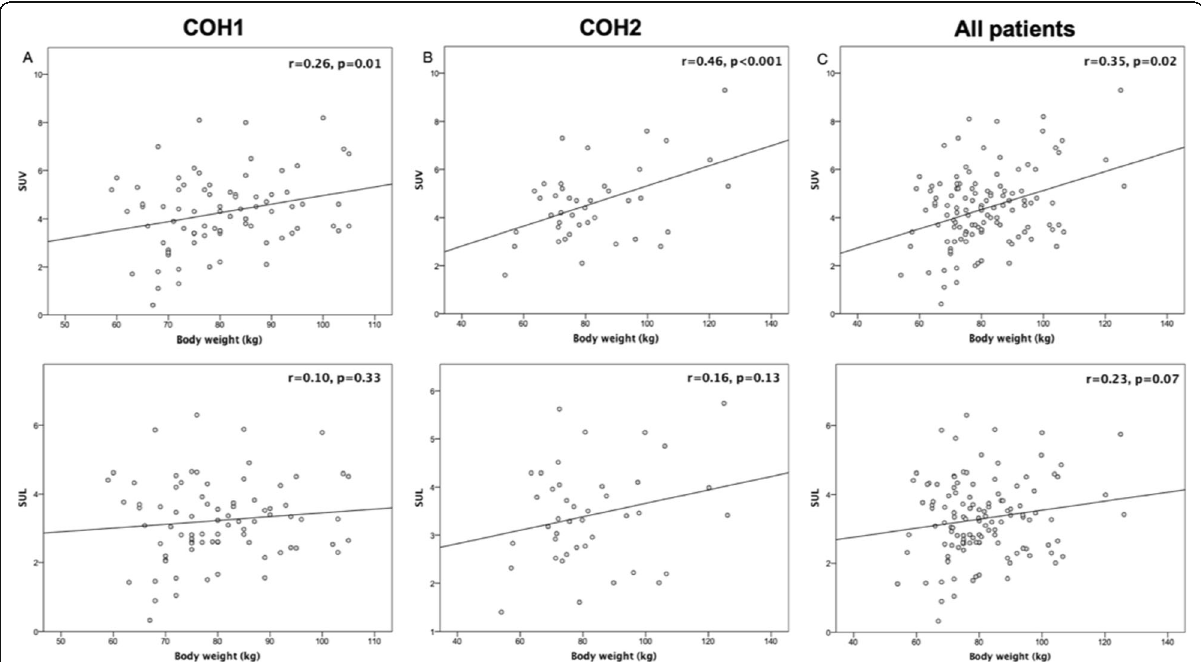
Fig. 1 Scatter plots of both SUV and SUL correlations with body weight for a COH1, b COH2, and c all